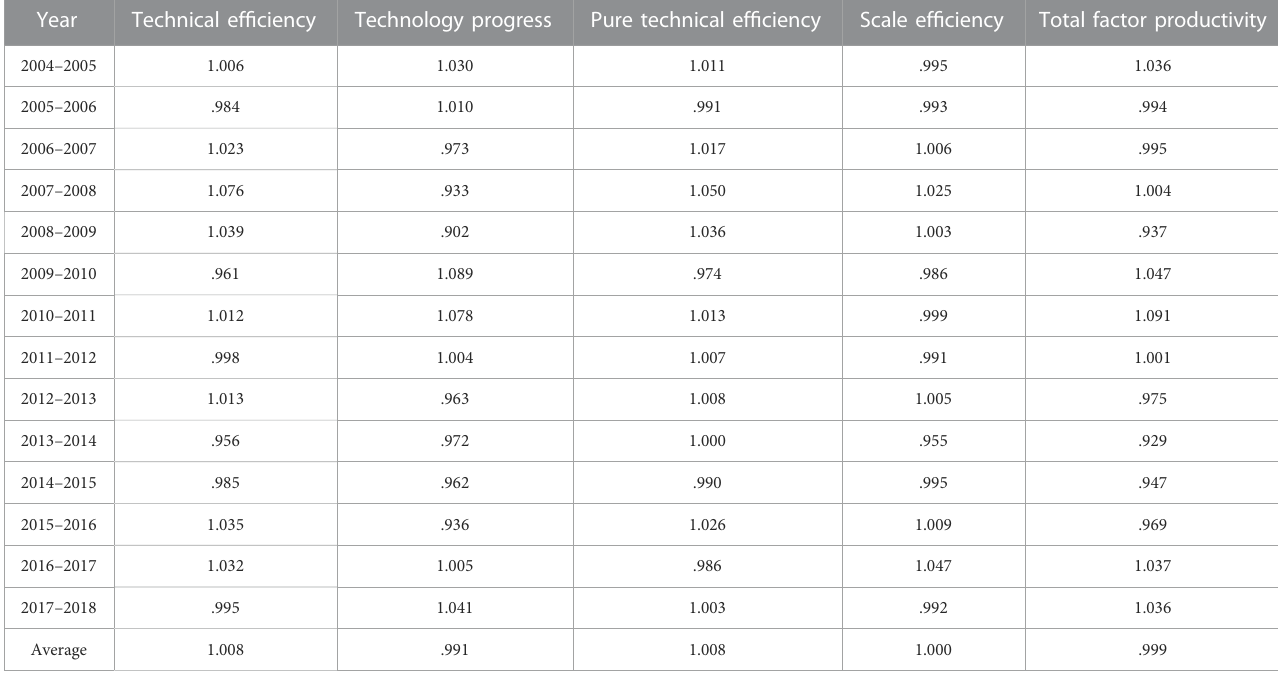
TABLE 5 Average Malmquist index and its decomposition by year in oil and gas cities in 2004 –